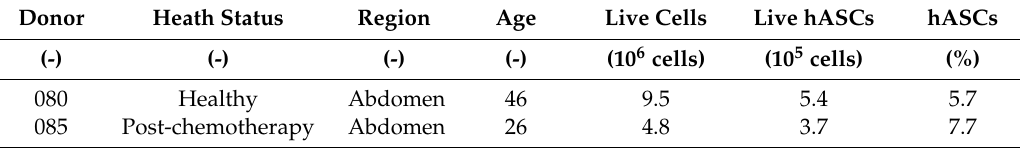
Table 2. Results obtained from the two di ff erent patients.